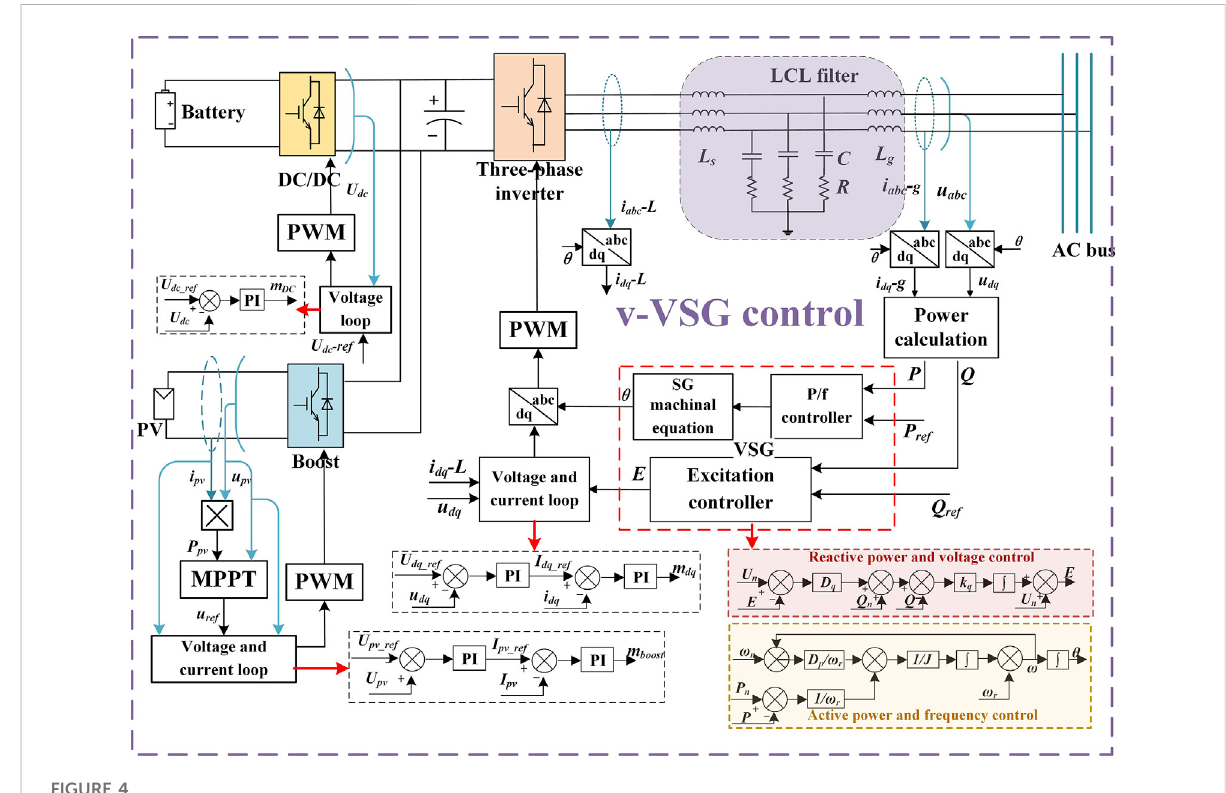
FIGURE 4 The control diagram of the integrated